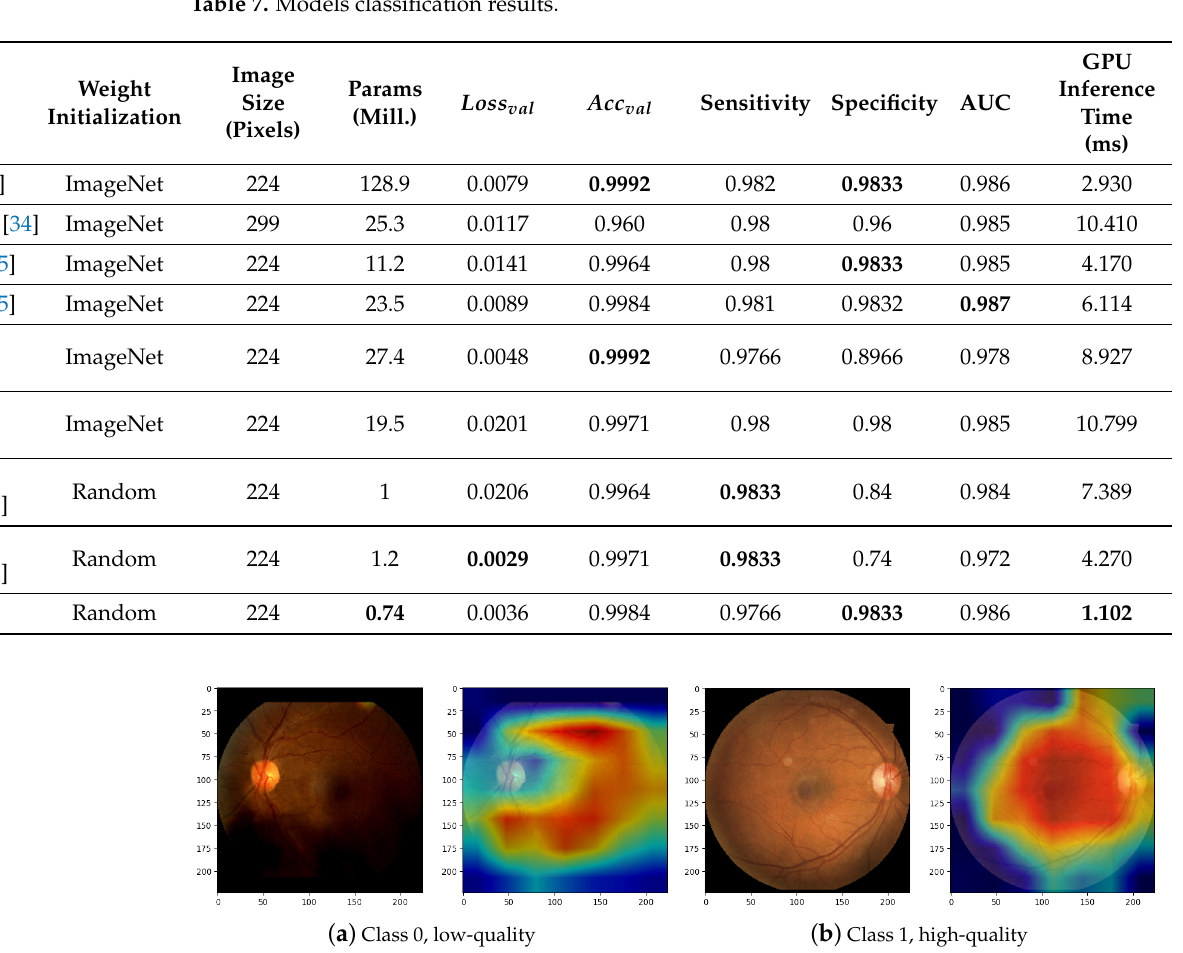
Table 7. Models classification results.